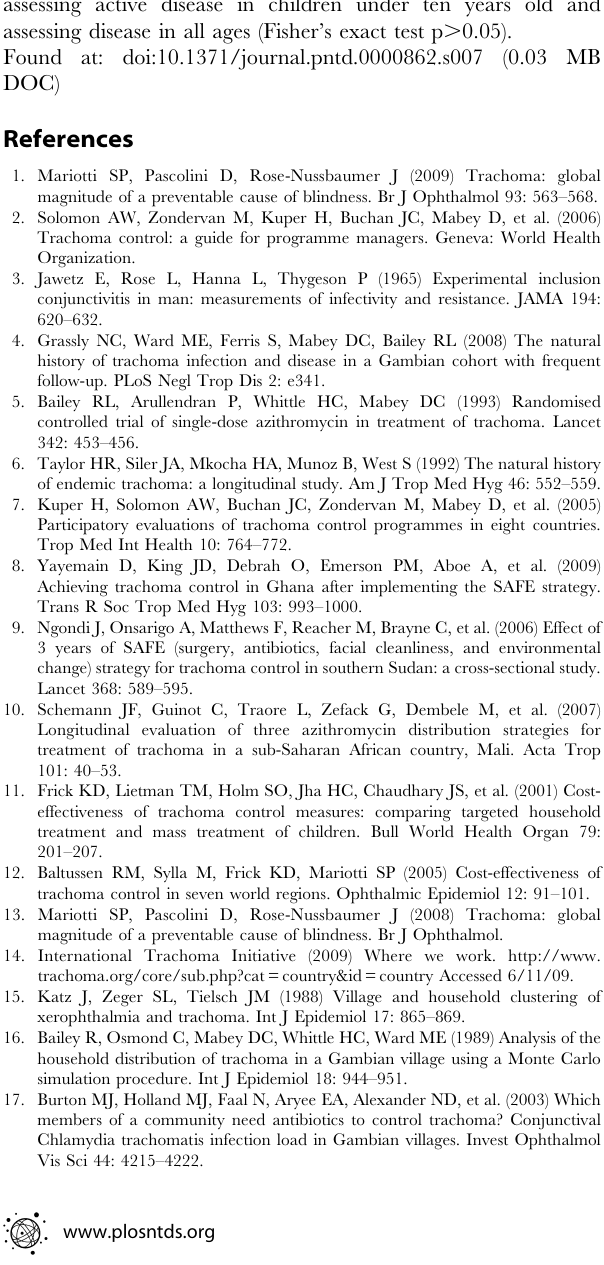
numbers in the square brackets are 95% binomial confidence intervals. Table S2 Comparison of Different Trachoma Transmission Models Fitted to Infection Data.